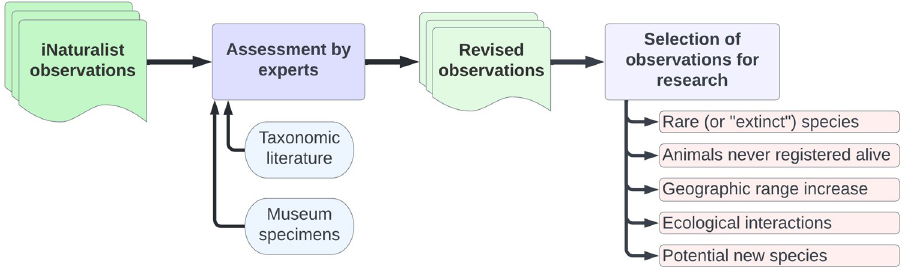
Fig 1. Workflow diagram. Diagram summarizing our workflow, starting with “raw” iNaturalist observations, through assessment of species identification, up to the selection of observations of interest.